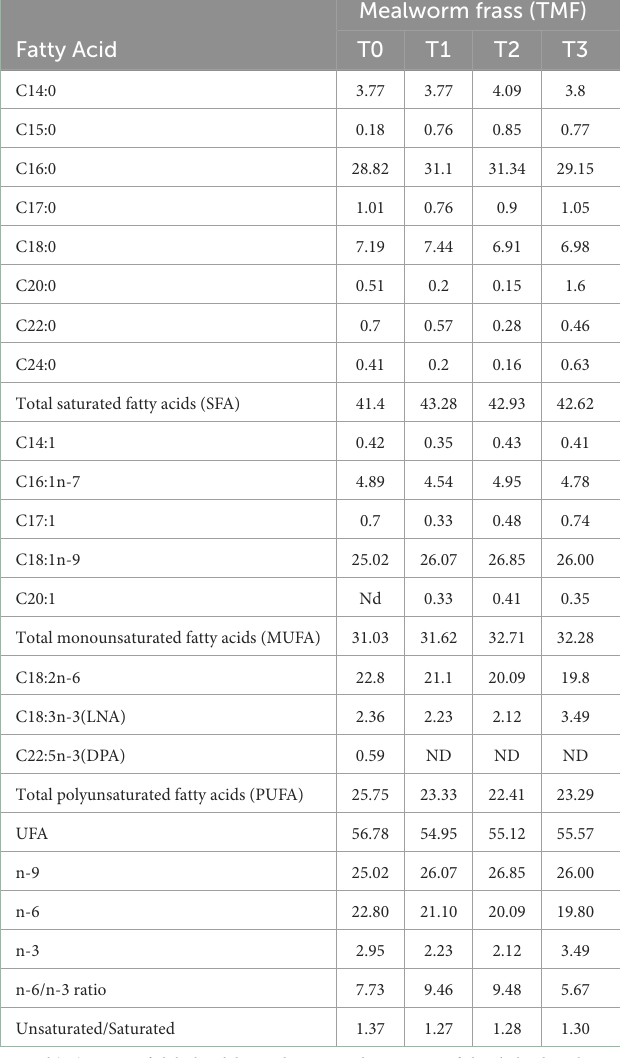
TABLE 7 Least square means ± standard error of fatty acid profile in the meat of the different groups studied (g/100g of total acid methyl esters). Mealworm frass (TMF)